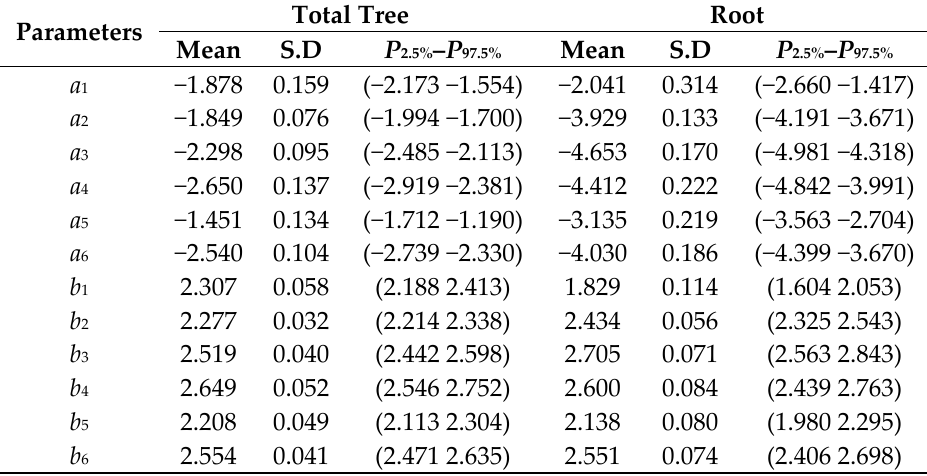
Table 5. Tree biomass model parameters using the Bayesian hierarchical approach ( a 1 – a 6 and b 1 – b 6 represent the six regions from L1 –